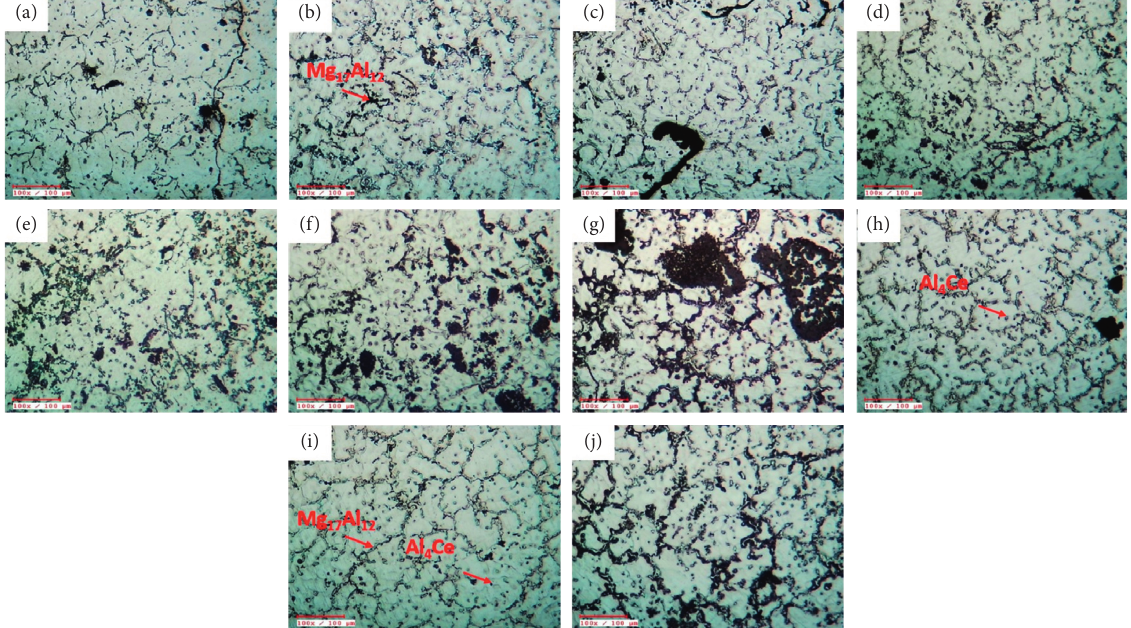
Figure 2: Microstructure of AZ91D+Xwt.%Ce